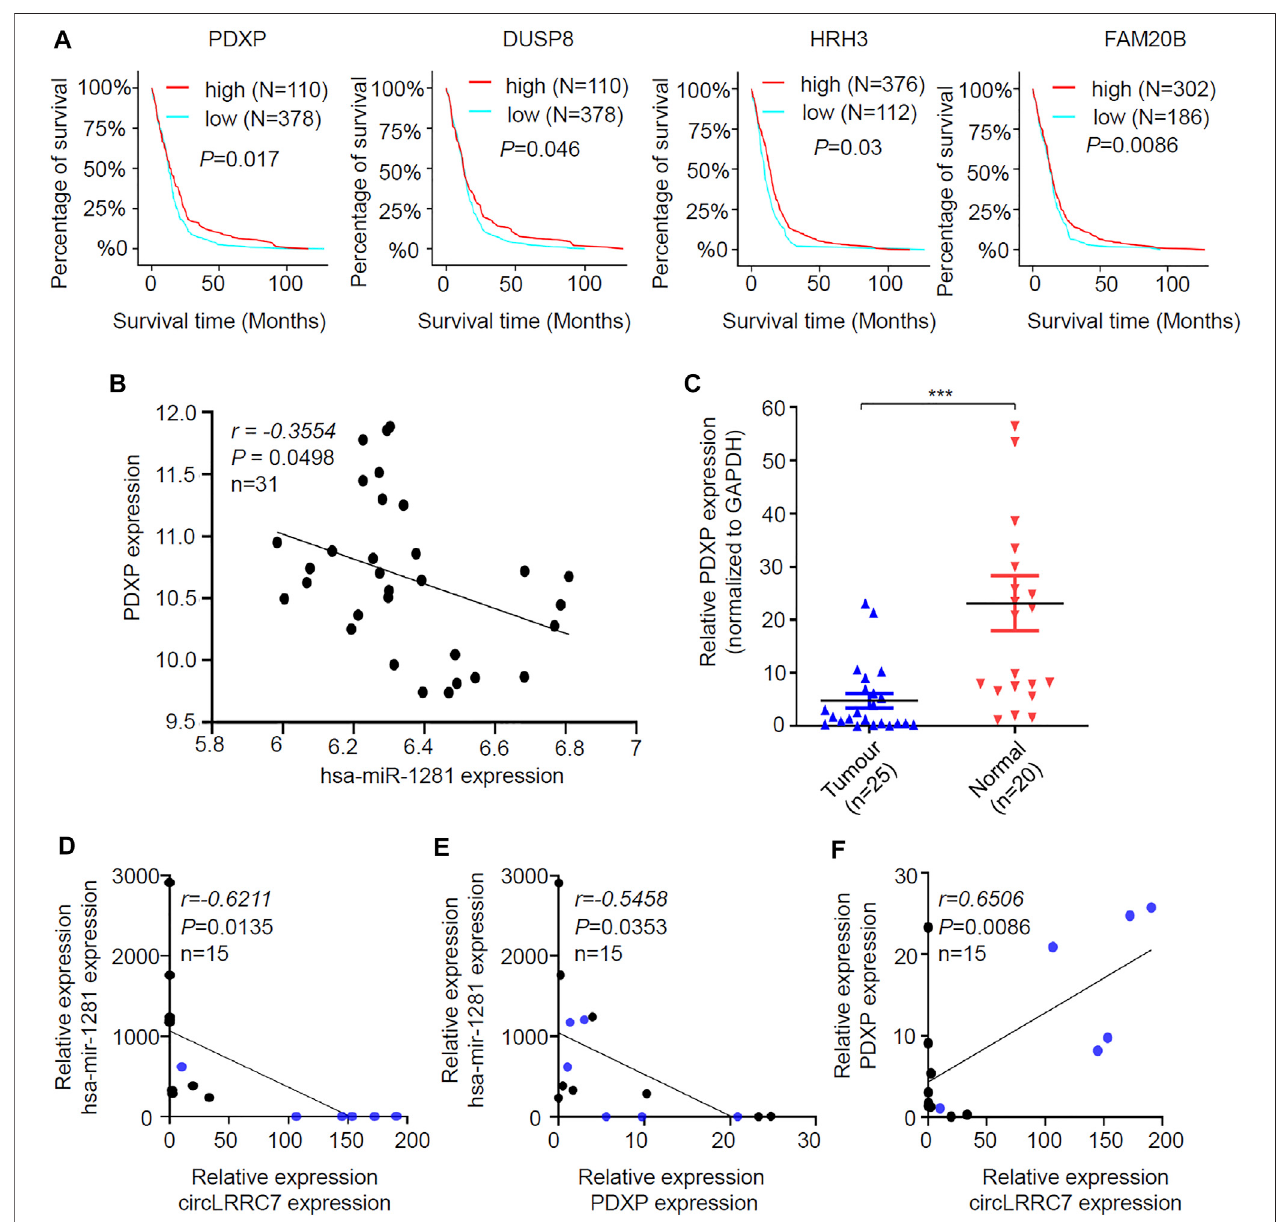
FIGURE 7 | Identi fi cation of the potential circLRRC7-miR-1281-PDXP axis in GBM. (A) The impact of PDXP, DUSP8, HRH3, and FAM20B on the prognosis of GBM patients. (B) Correlation analysis of the Gliovis database revealing the negative correlation between miR-1281 and PDXP in GBM and brain tissues. (C) qPCR analysisofthePDXPlevelsinGBMandbraintissuescollectedinourhospital. (D) LineageregressionanalysisforthecorrelationbetweencircLRRC7andmiR-1281in15 brainandGBMtissues.circLRRC7levelswerenegativelycorrelatedtomiR-1281. (E) LineageregressionanalysisforthecorrelationbetweenmiR-1281andPDXP in15brainandGBMtissues.circLRRC7levelswerenegativelycorrelatedtomiR-1281. (F) LineageregressionanalysisforthecorrelationbetweencircLRRC7andPDXP in 15 brain and GBM tissues. circLRRC7 levels were positively correlated to PDXP. Blue dots represent normal tissues and black dots represent tumor tissues. (*** p <